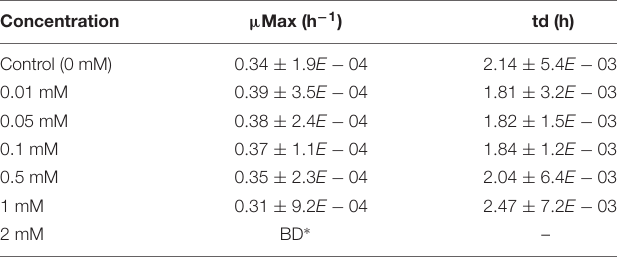
TABLE 1 | Specific growth rate and doubling time values for Thermus scotoductus SA-01 grown in different Eu (0, 0.01, 0.05, 0.1, 0.5, 1, and 2 mM) concentrations.